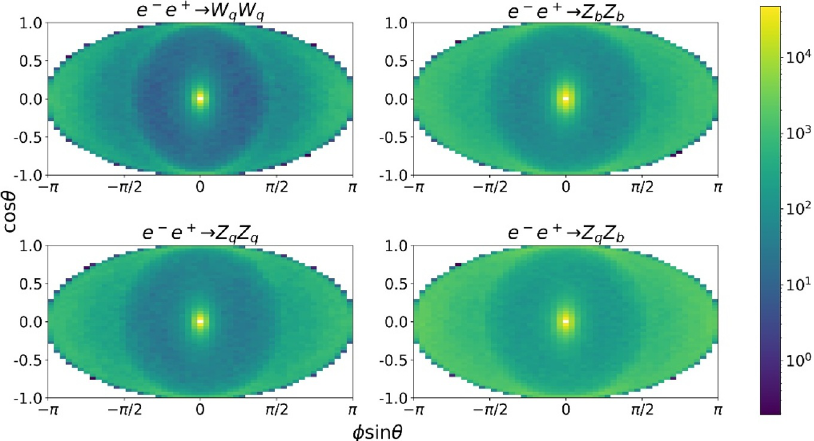
Figure 10 . Cumulative Mollweide projections of 10000 events: W q W q (upper-left), Z b Z b (upper- right), Z q Z q (bottom-left) and Z q Z b (bottom-right), with the brightness of each cell scaling with the total energy (GeV) of the particle hits